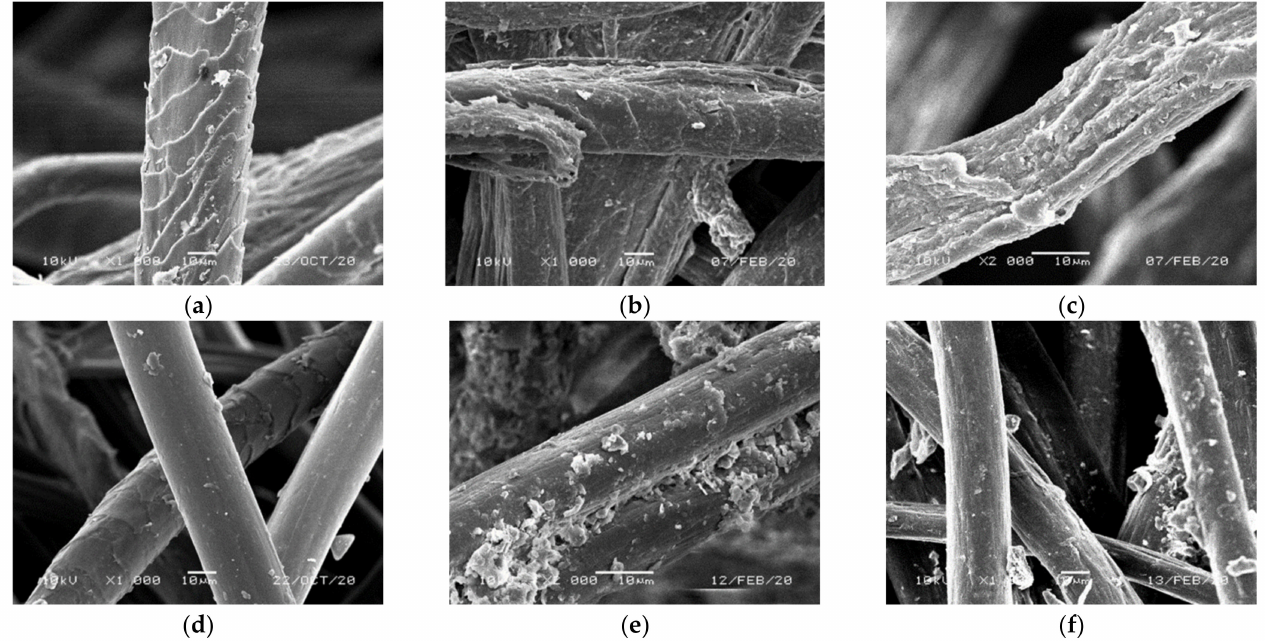
Figure 12. Changes in the morphology of the fibers of the rope depending on the material type. ( a ) Original wool fiber; ( b ) wool fiber from the wool rope surface 47 months after installation; ( c ) wool fiber from the wool rope core 47 months after installation; ( d ) original recycled natural and synthetic fibers; ( e ) recycled natural and synthetic fiber from the RNSF rope surface 47 months after installation; ( f ) recycled natural and synthetic fiber from the RNSF rope core 47 months